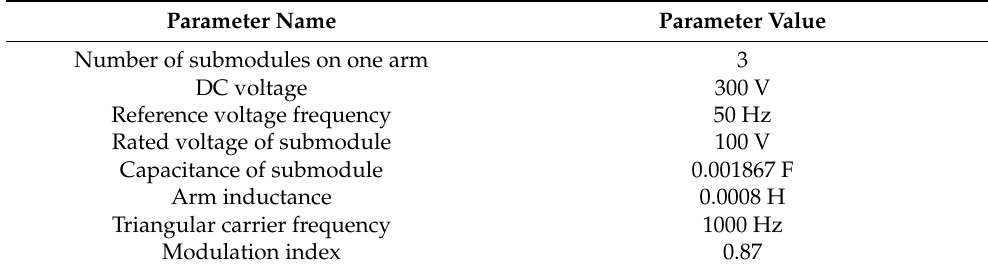
Table 1. Parameter table of MMC simulation model.